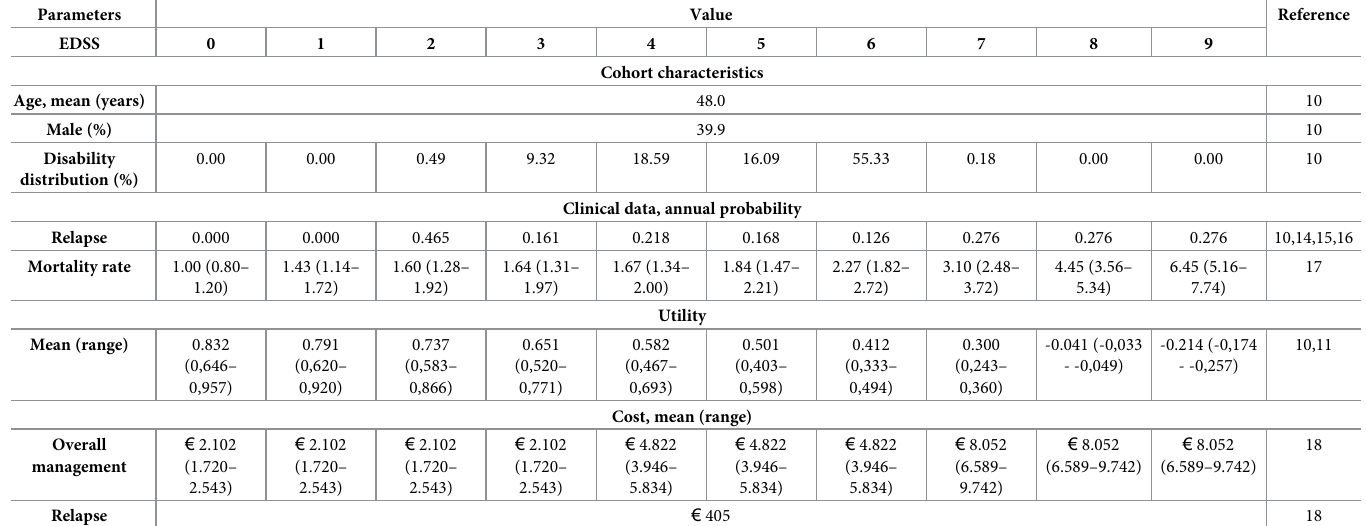
Table 1. Clinical, quality of life and management cost data input.